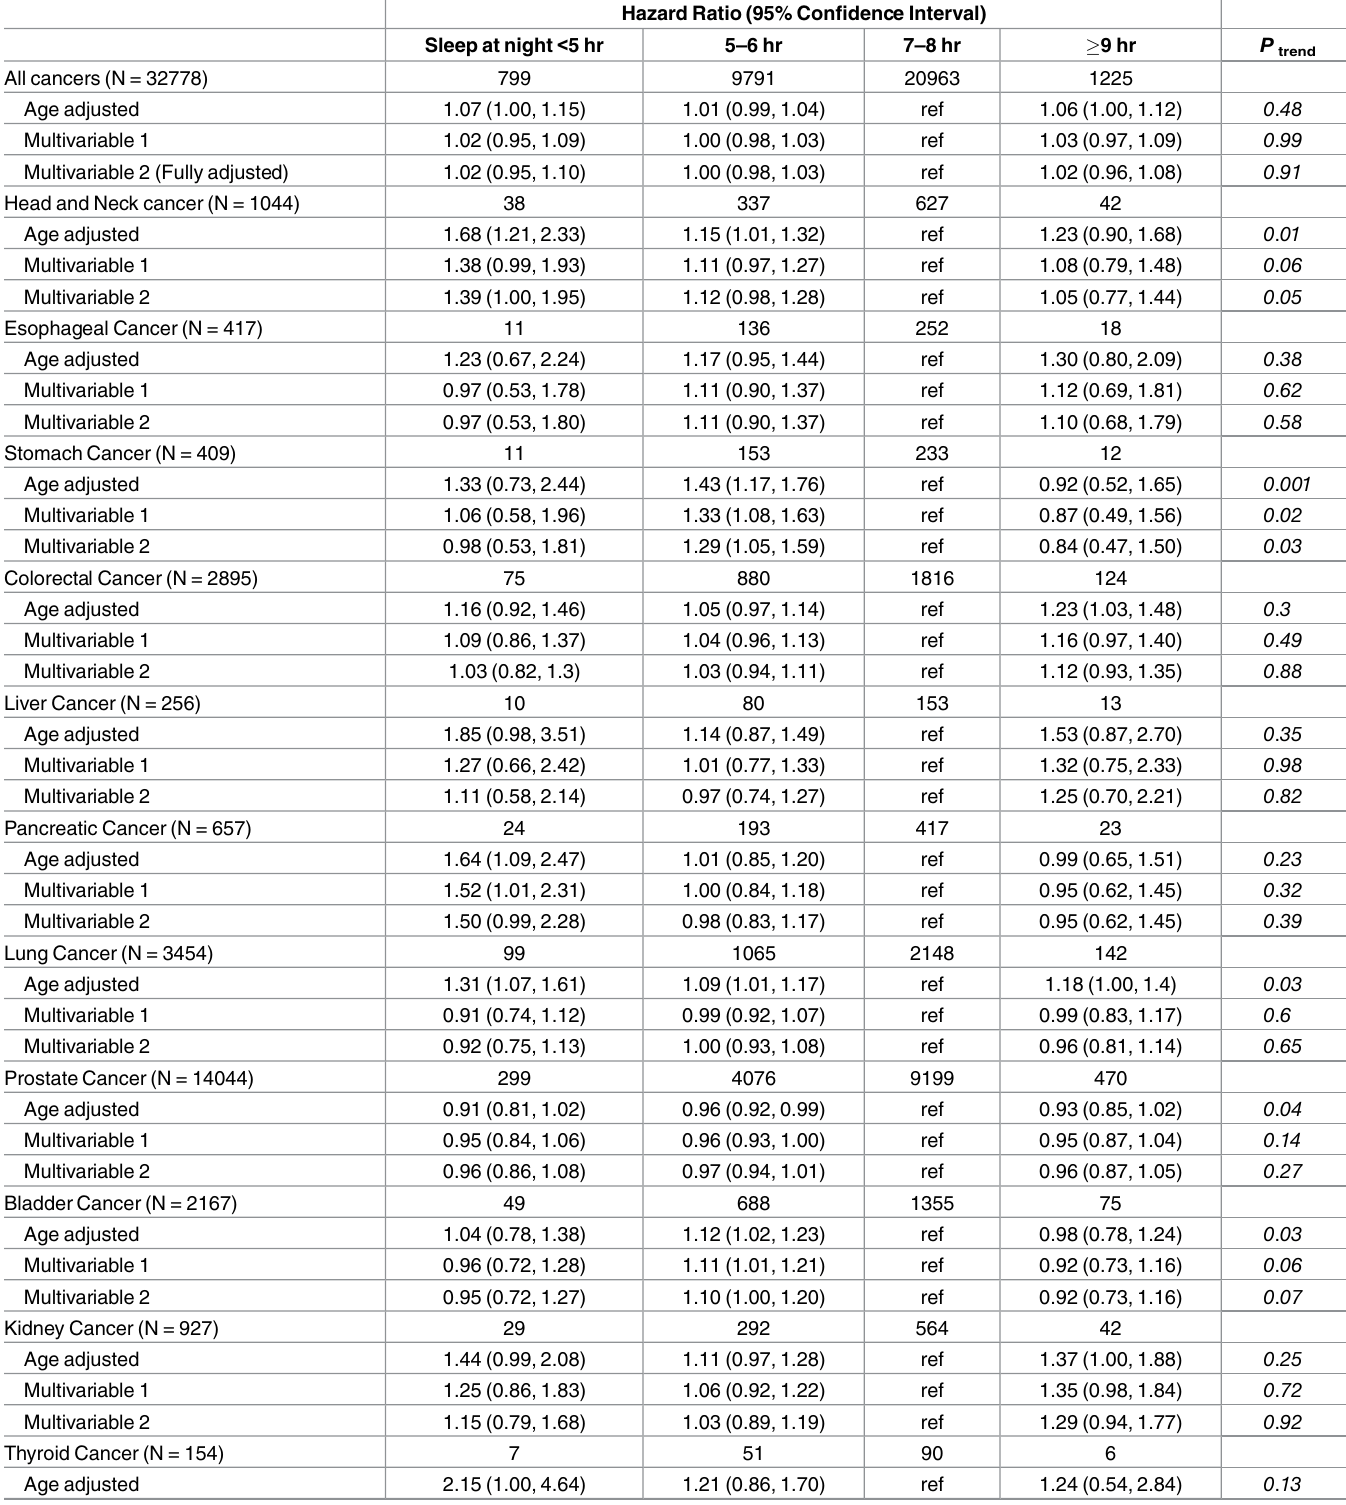
Table 2. Associationbetween nighttime sleepdurationand cancerincidence in